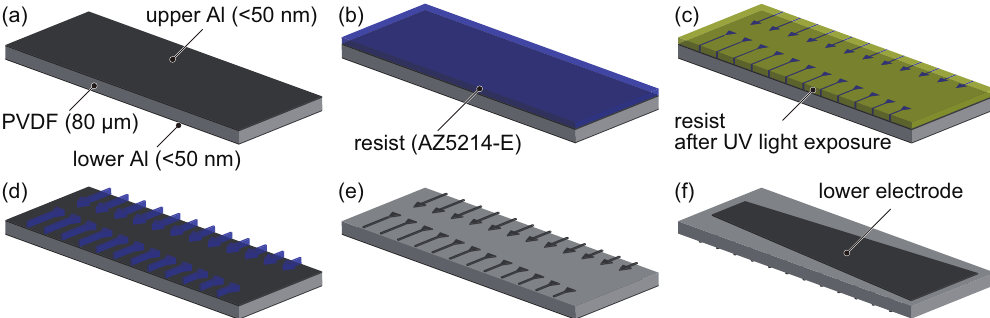
Figure 2. Fabrication process for the patterned electrodes deposited on the PVDF membrane. ( a ) Al electrodes are deposited on both the upper and lower sides of the PVDF membrane. ( b ) The upper electrode is spincoated with photoresist AZ5214-E. ( c ) The resist is exposed to ultraviolet light. ( d ) The exposed photoresist is developed using a developer solution. ( e ) The uncovered electrodes are etched during the development, and the photoresist is removed. ( f ) The lower electrode is prepared using the same